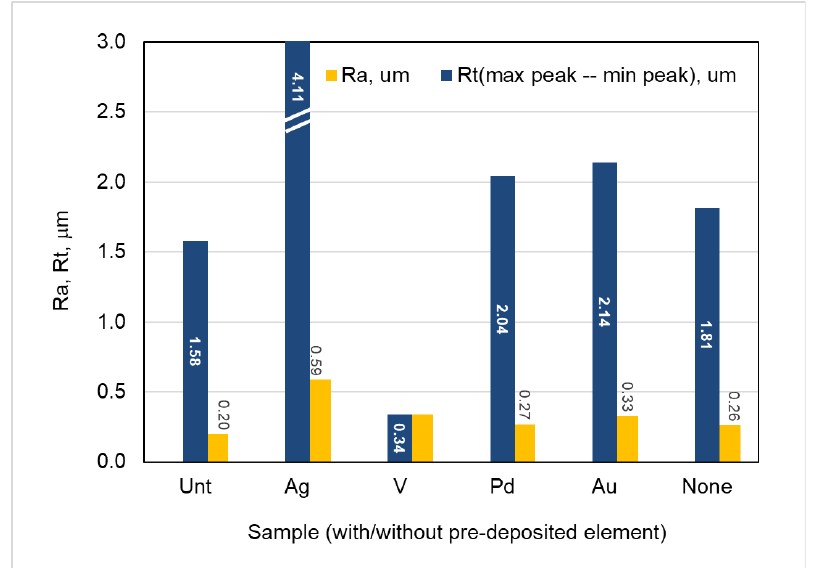
Figure 3. The average Ra and Rt values of the samples after ceramic conversion treatment at temperature 600 °C for 10 h, with and without pre-deposition element, as indicated, compared with untreated substrate sample.